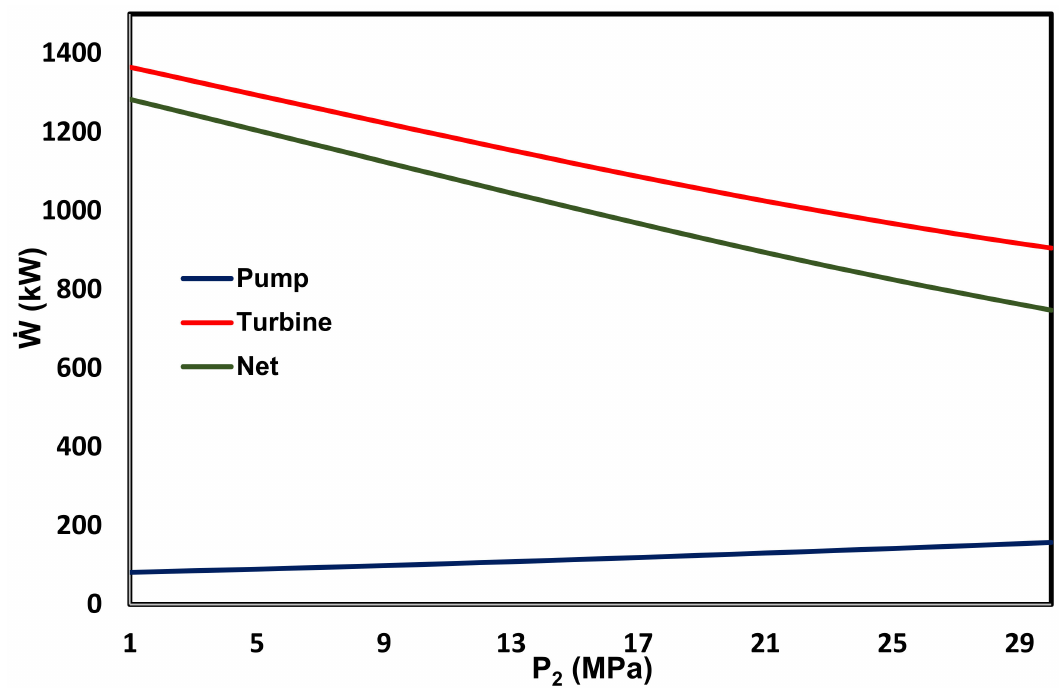
Figure 7. The changes in pump and turbine electrical power consumption/production and net output power of the CO 2 cycle with the variation in pump outlet pressure (P 2 ) in the CO 2